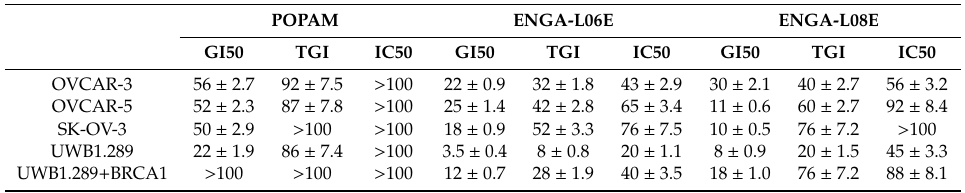
Table 1. In vitro growth inhibition / cytostatic [50% Growth Inhibition (GI 50 ) and Total Growth